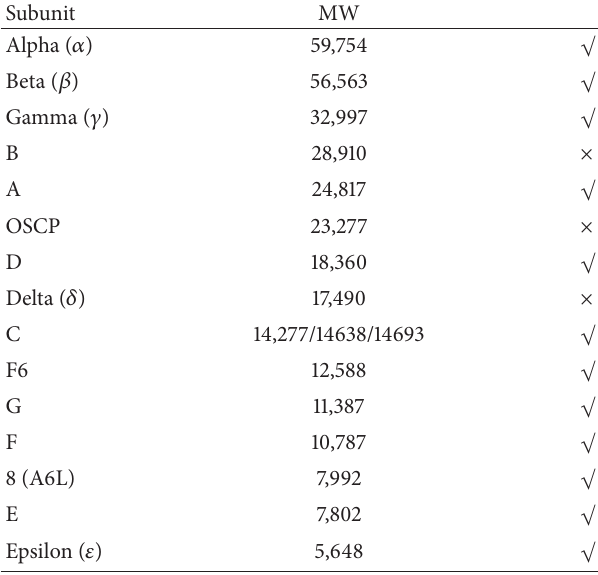
Table 1: Molecular weight of each subunit of complex V ∗